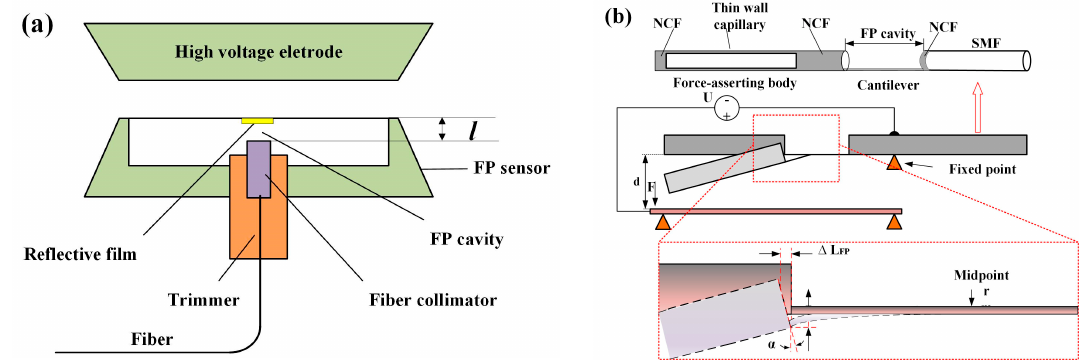
Figure 16. ( a ) Schematic of sensor probe [111], ( b ) configuration of sensor head and the operating principle [112].